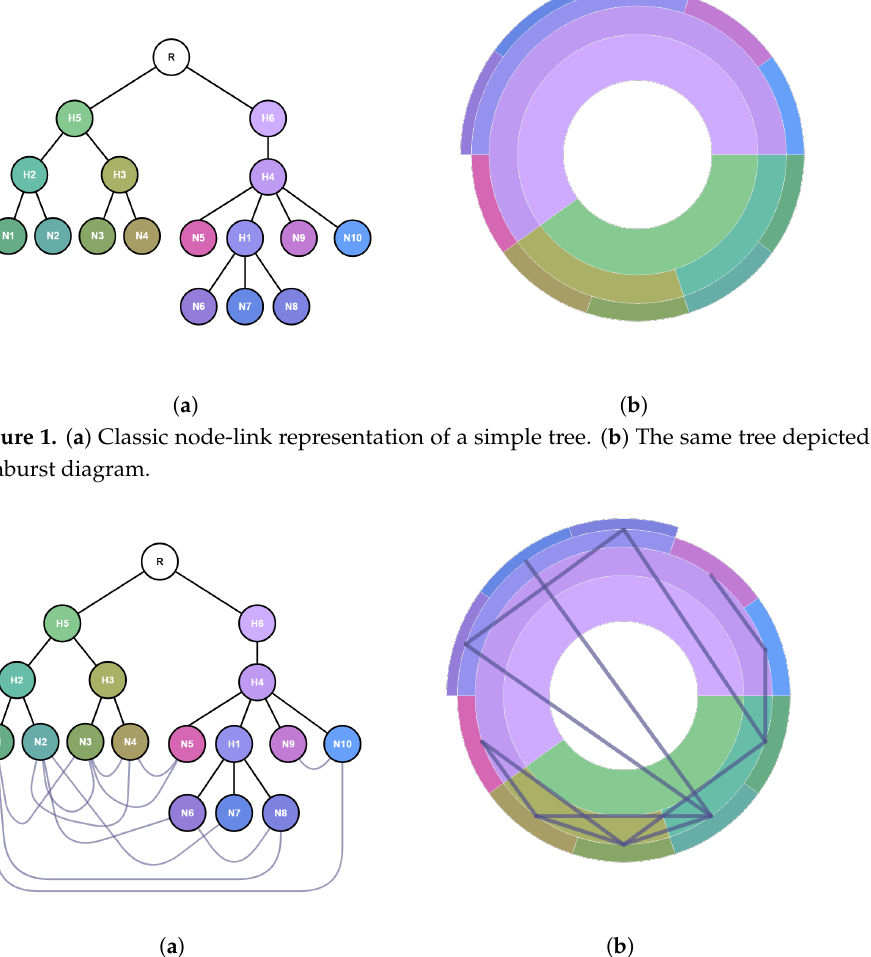
Figure 2. ( a ) The same simple tree as in Figure 1, adding adjacency relationships between leaf nodes. ( b ) Inclusion edges are represented by the sunburst diagram while the adjacency relations are depicted with edges connecting the incident leaf